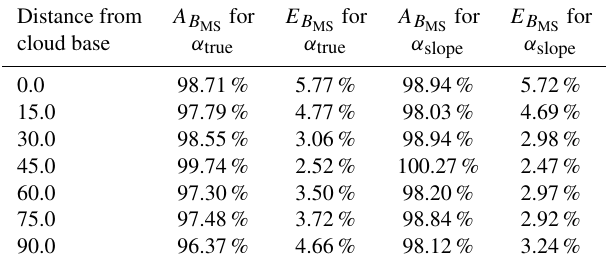
Table 3. Mean error and accuracy of the cloud optical thickness ex- tinction retrieval for different heights above the cloud base. Data are retrieved by inverting simulated multiple scattering signal ( B MS ) with both the resolution and the multiple scattering correction, with α 0 equal to the true extinction at the normalisation height z 0 (de- noted as α true ) and, in the second case, with the α 0 estimate calcu- lated from Eq. (7) (denoted as α slope